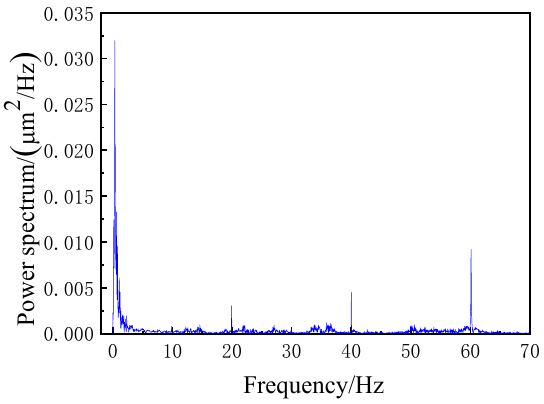
Figure 11. Power spectrum of measurement point 1 under condition 2.